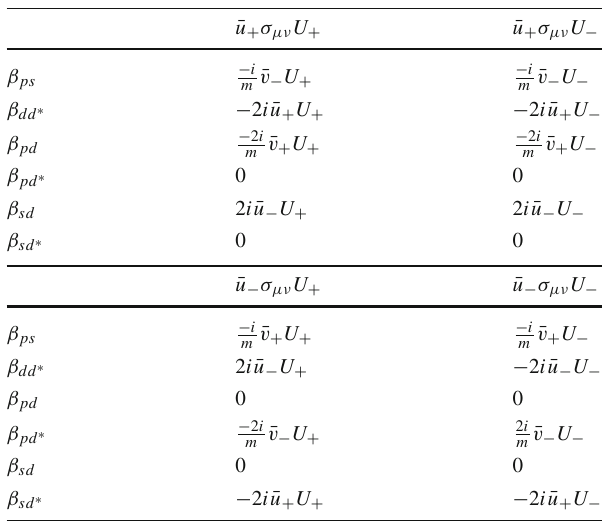
Table 2 Expansion coefficients according to Eq.